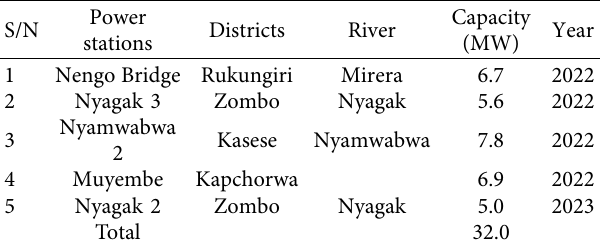
Table 6: Small hydropower plants under